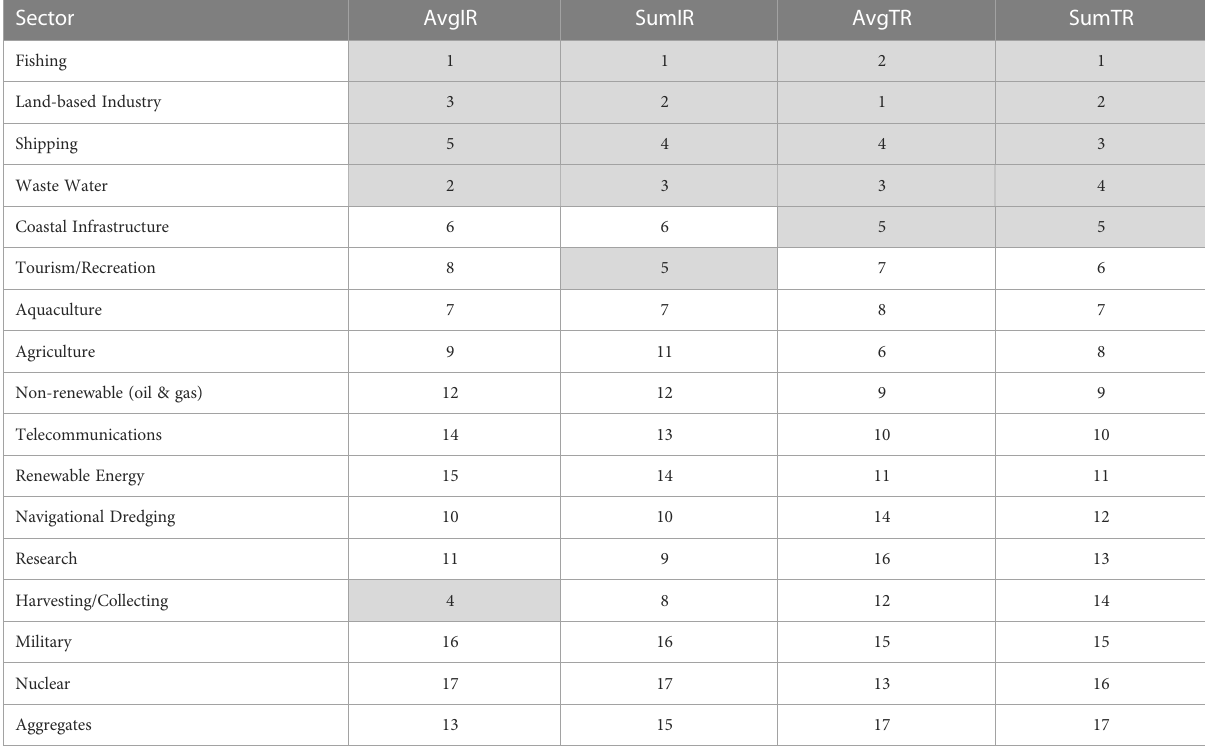
TABLE 3 Ranks for each sector and ranking index used.